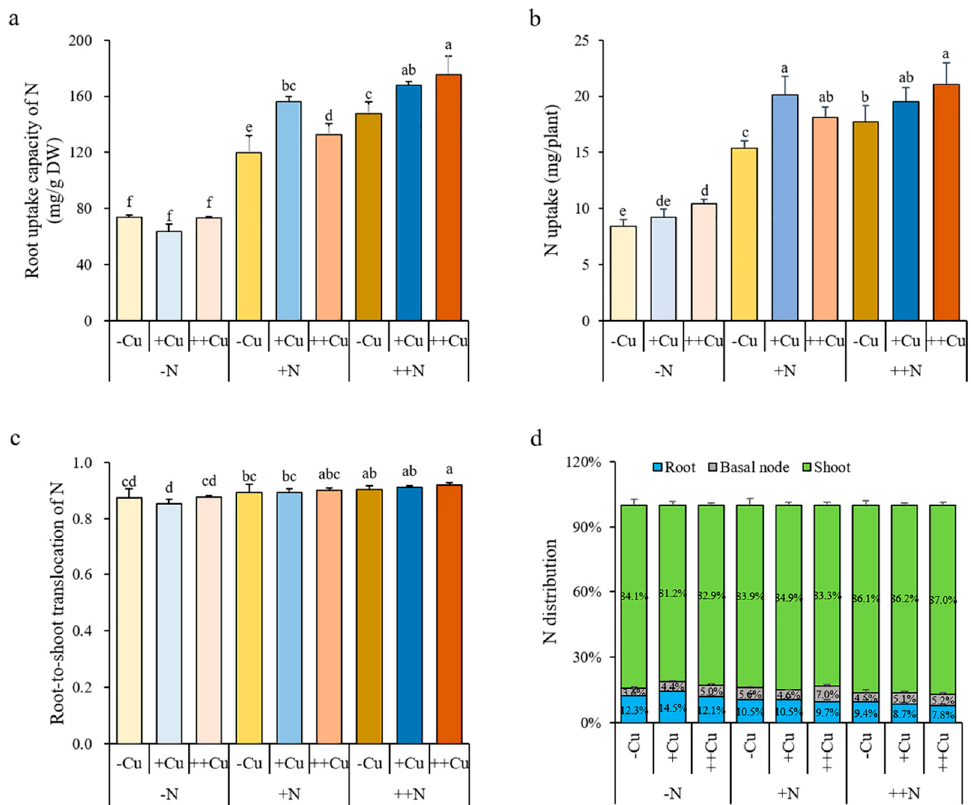
Figure 3. Root uptake capacity of N ( a ), N uptake in whole plant ( b ), root-to-shoot translocation of N ( c ), and N distribution ( d ) of rice plant grown in solutions with different combinations of Cu (-Cu, 0 µ M; +Cu, 0.15 µ M; ++Cu, 1.5 µ M) and N (-N, 0.288 mM; +N, 2.88 mM; ++N, 14.4 mM) supply for three weeks. The N uptake was calculated as the N accumulation of whole plant; the uptake capacity of N was calculated as the N accumulation of whole plant/root dry weight; the root-to-shoot translocation of N was calculated as the N accumulation in shoot/the N accumulation of whole plant; the N distribution in each organ was calculated as the N accumulation in each organ/the N accumulation of whole plant. Data are means ± SD of three biological replicates. Different letters indicate significant difference at p < 0.05 by Tukey’s test.